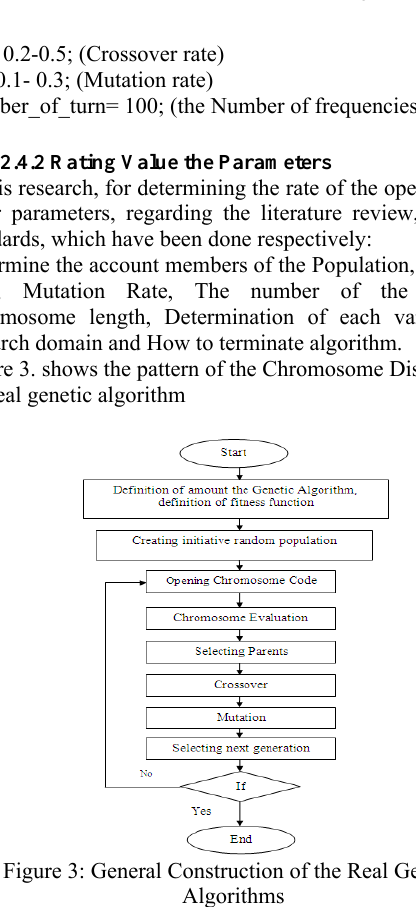
Figure 5: the map cost for the crops in the three scenarios